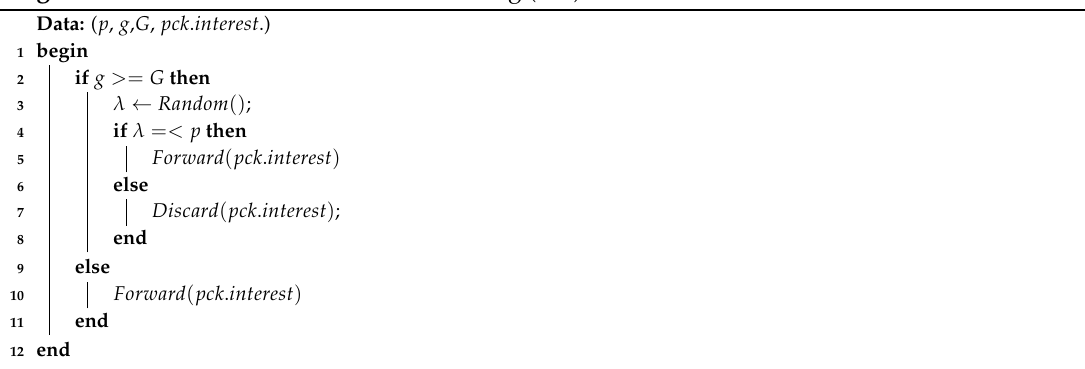
Algorithm 1: Probabilistic Interest Forwarding (PIF) Mechanism.